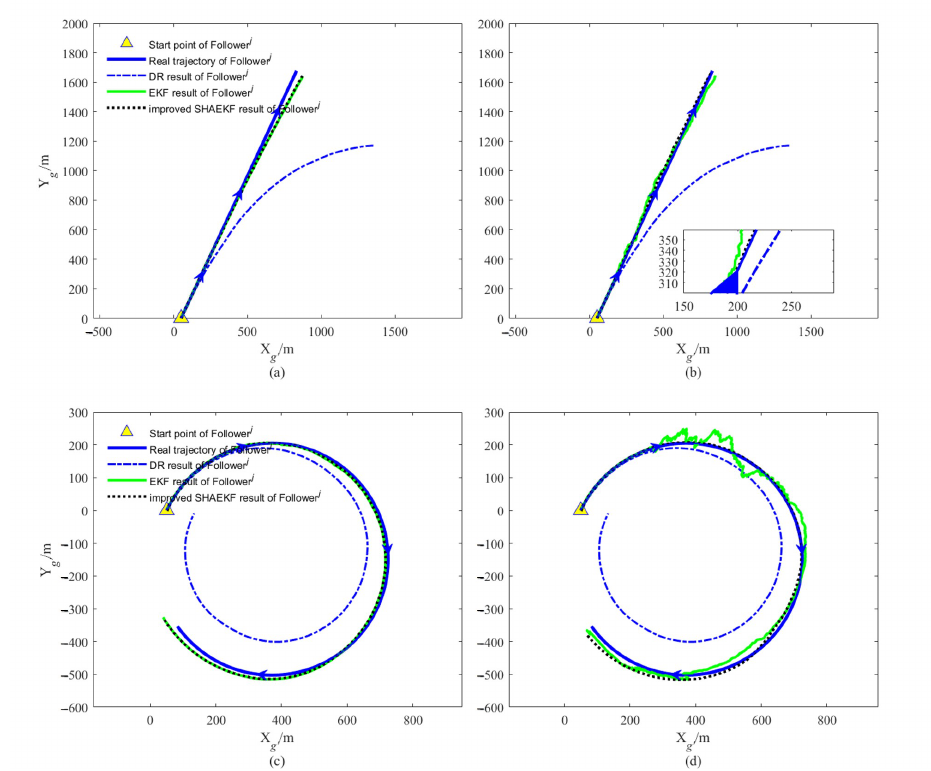
Figure 4. Trajectory diagram of Follower j in a test. ( a , c ) The localization results of each algorithm without measurement anomaly are described; ( b , d ) the localization results of each algorithm in the presence of measurement anomalies are